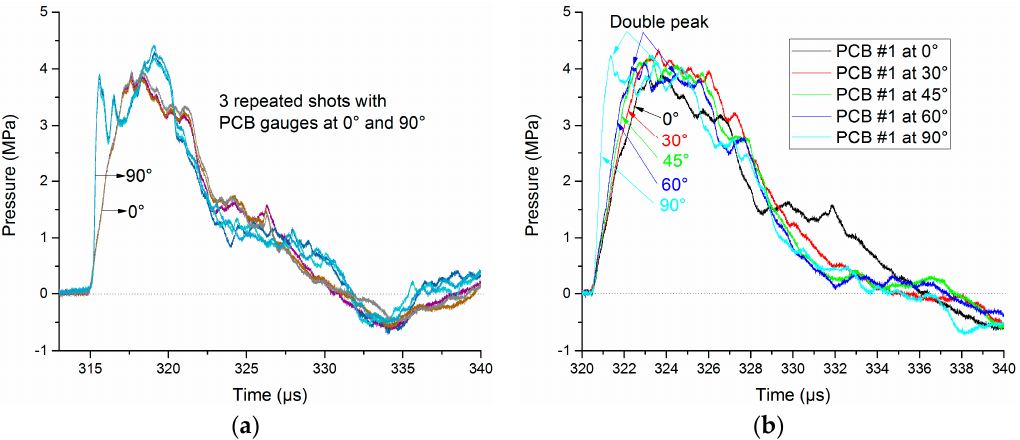
Figure 6. Pressure signals obtained by the PCB138 probe with different incident angles at the distance of 460 mm ( a ) Consistency of the obtained pressure waveforms; ( b ) rising edge of pressure signal with different incident angles.